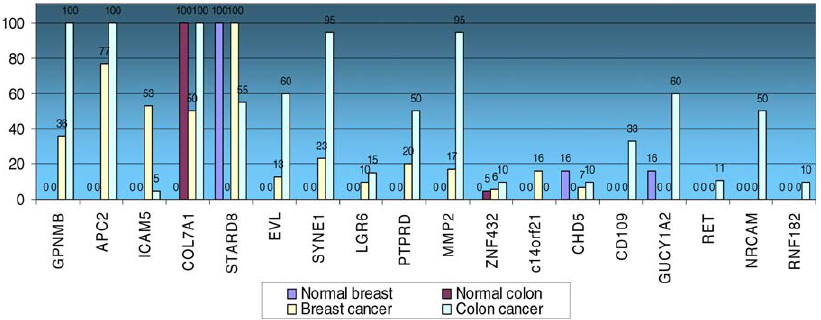
Figure 5. Frequency of Cancer-Specific Methylation of CAN Genes in Primary Breast and Colon Tumors For each gene, results are shown in the following order: normal breast, normal colon, breast cancer, colon cancer. doi:10.1371/journal.pmed.0050114.g005 PLoS Medicine |